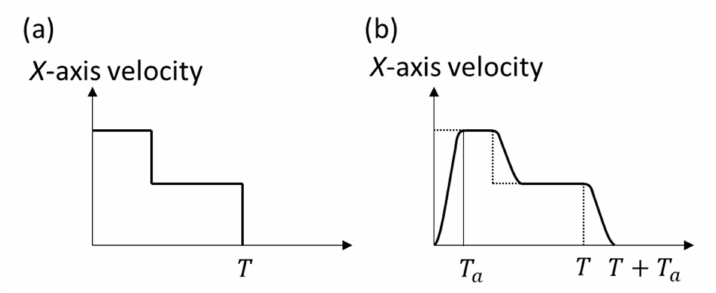
Figure 3. ( a ) Velocity profiles in the Acc/Dec after interpolation (ADAI). ( b ) Velocity profiles out of the ADAI [25].